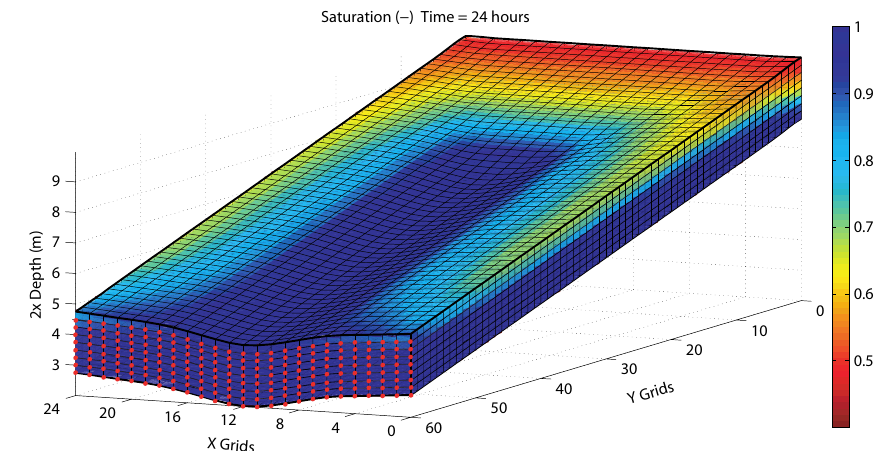
Figure 3. Discretization of the LEO soil with a grid of 60 × 24 × 8 cells and 61 × 25 × 9nodes (the vertical depth of soil is exaggerated by a factor of 2). The red dots at the lower end of LEO represent the 25 × 8nodes seepage face. Color indicates the modeled degree of saturation at time 24h of the best realization ( n =2.26 in Fig. 9).